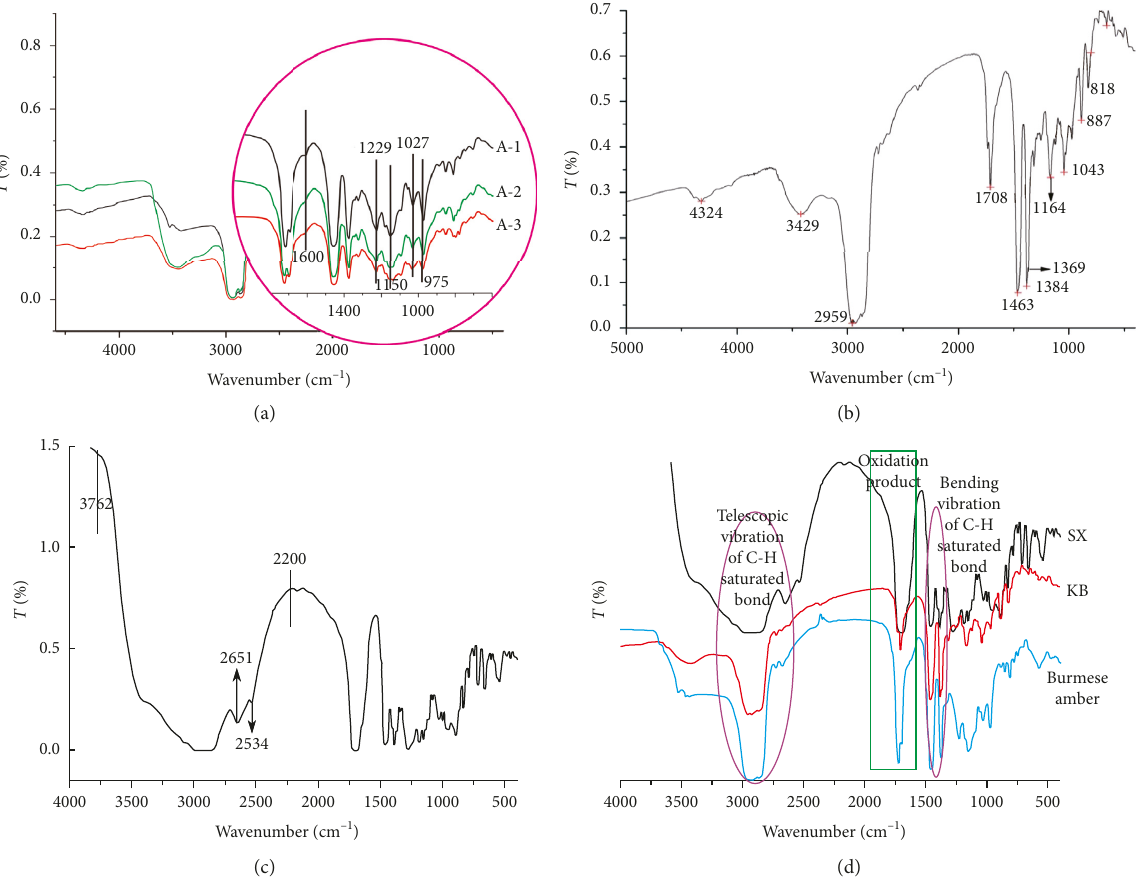
Figure 2: Infrared spectra of amber, copal, and rosin samples: (a) amber samples (A-1, A-2, and A-3); (b) copal sample (KB); (c) rosin sample (SX). (d) Comparison of amber, copal, and rosin (the amber spectrum shown in the average of the three amber